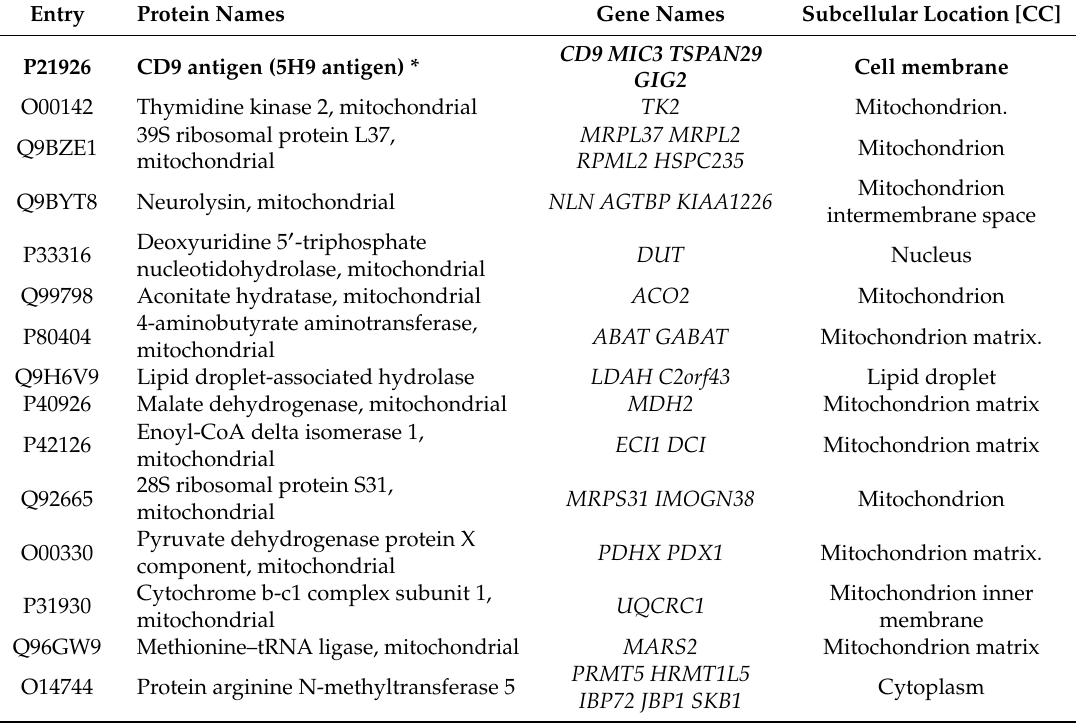
Figure 4. Results of the annotation clustering by Bionic Visualizations Proteomaps. Di ff erent levels of information are shown, with a higher level meaning a more in-depth analysis: in ( A ), level 1 clustering; in ( B ), level 2 clustering, and in ( C ), level 3 clustering is shown. The larger the area the more proteins are assigned to the respective category. Terms are clustered in six main categories, as can be seen in ( A ), indicated by color: human diseases (black), environmental information processing (cyan), genetic information processing (blue), metabolism (yellow), cellular processes (red), and organismal systems (pink). Many proteins of the core proteome are connected in the yellow coded area metabolism ( A ). In level 2 ( B ), biosynthesis is prominent, while more in-depth analysis at level 3 ( C ) shows strong connection to terms like amino acid metabolism, lipid and steroid metabolism, and cofactor biosynthesis (for further details see Supplemental Figure S1A–D). Table 3. Di ff erentially expressed proteins (overlap of MaxQuant and Spectral Counting analysis) and their annotated subcellular